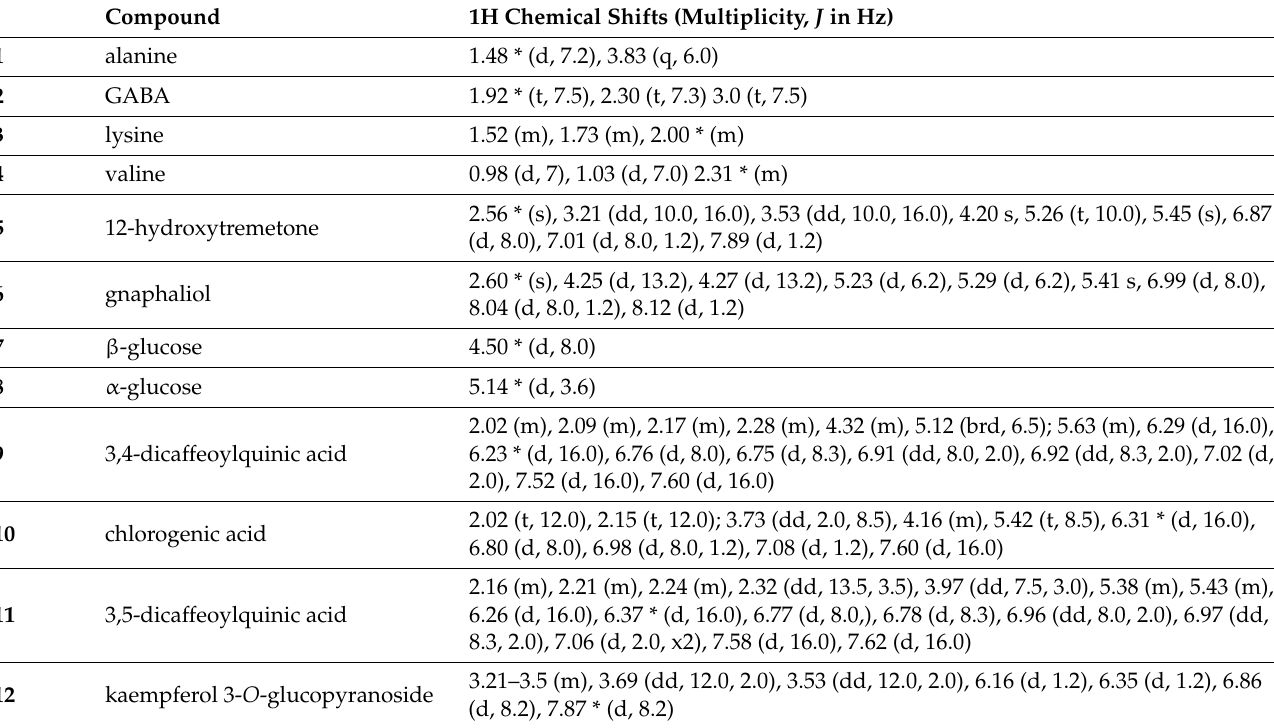
Figure 4. Secondary metabolites identified in derived food supplements of H. italicum . Table 1. Characteristic 1 H NMR peaks identified in H. italicum food